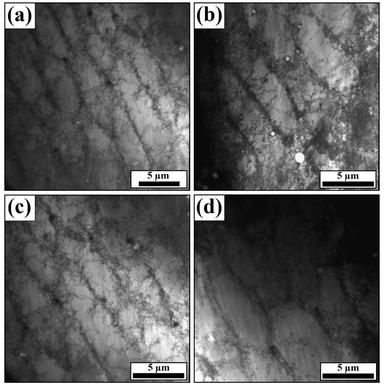
TEM images showing (a) the formation of the cellular structure by accumulation and intersection of statistically dislocations along the boundaries during rapid cooling, (b) distribution of reinforcing Al2O3 nanoparticles within the cells/sub-grains, (c) elongated, and (d) hexagonal cells in the ultra-fine range and micron scale.